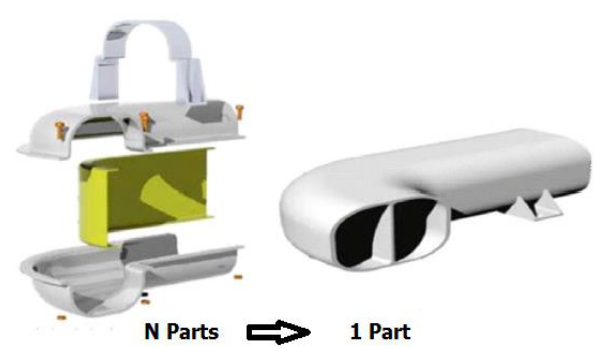
Fig. 1. Part consolidation